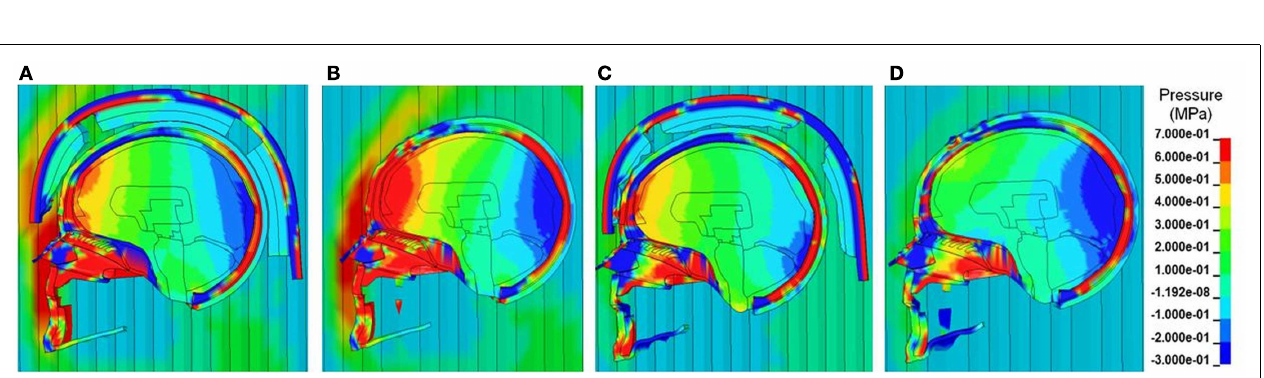
FIGURE 6 | Pressure contours across the face, scalp, skull and various intracranial components in the midsagittal plane at two selected time points (A, B)T = 2ms and (C, D)T = 3ms, when the blast wave interacting with the helmeted head (A, C) and non-helmeted head (B, D) (Case 3 blast loading condition)